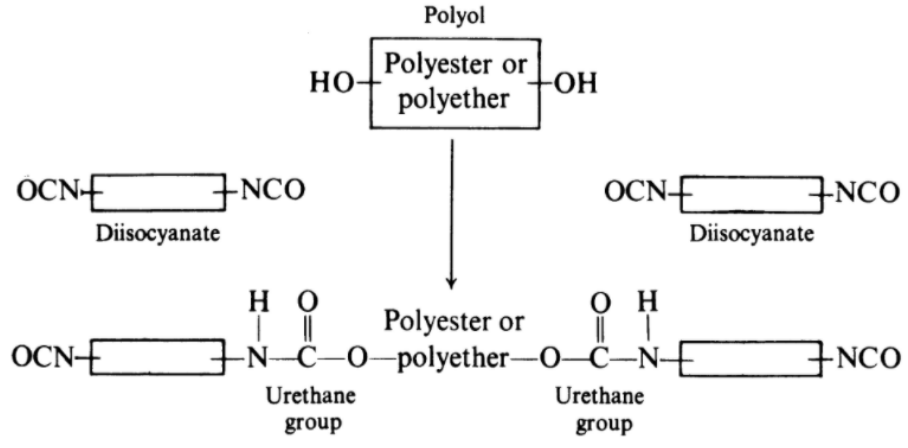
Figure 1. Typical synthesis reaction of polyurethanes [18] .